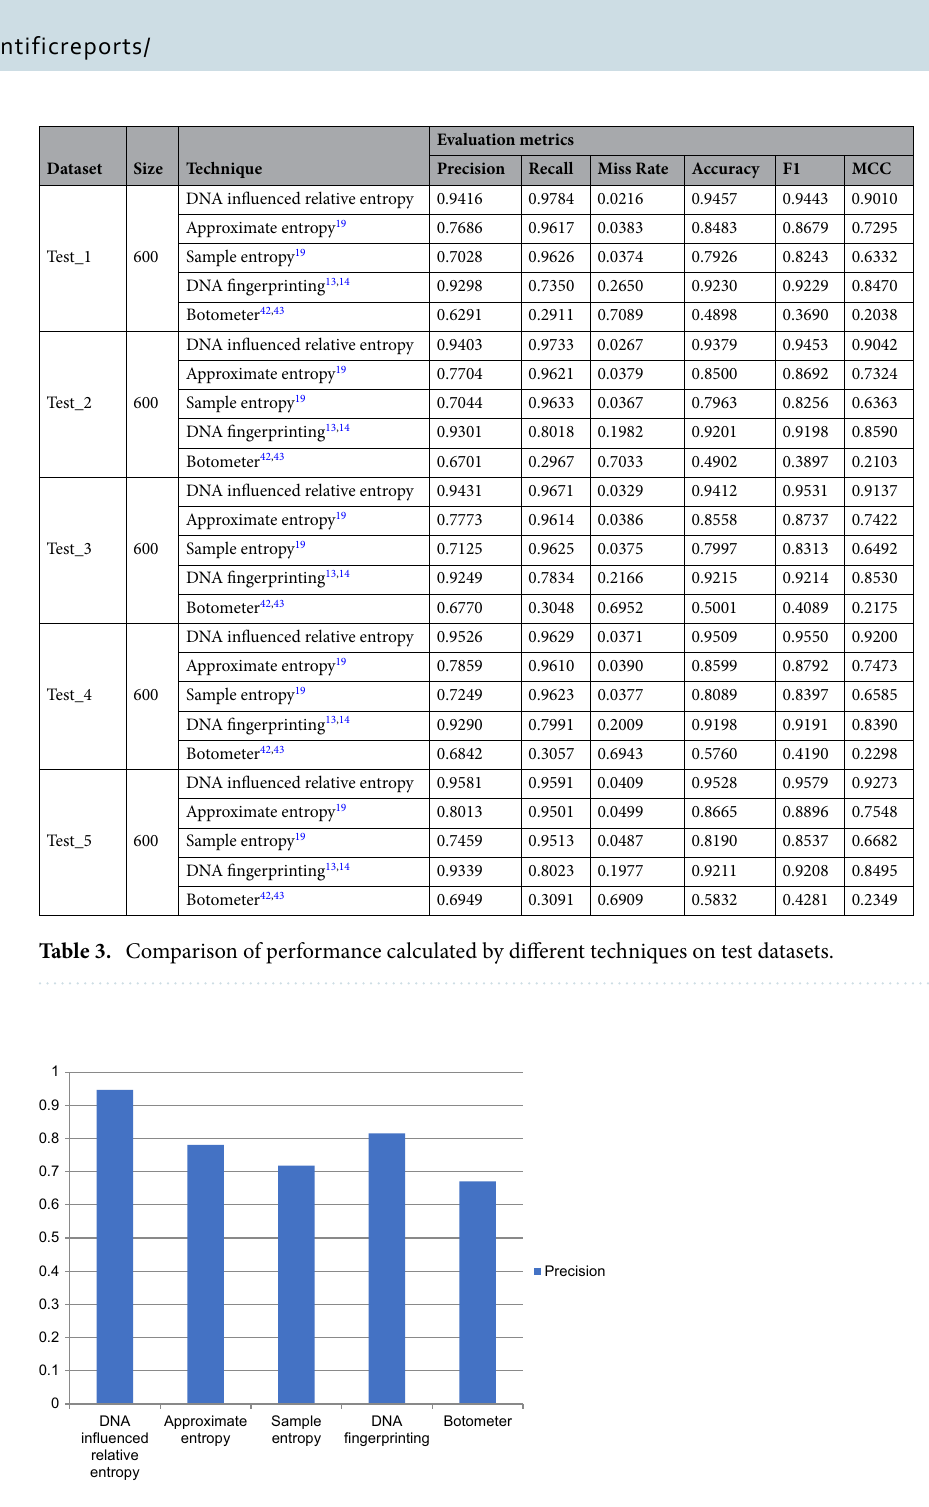
Figure 3. Comparison of Precision metric for different state-of-art